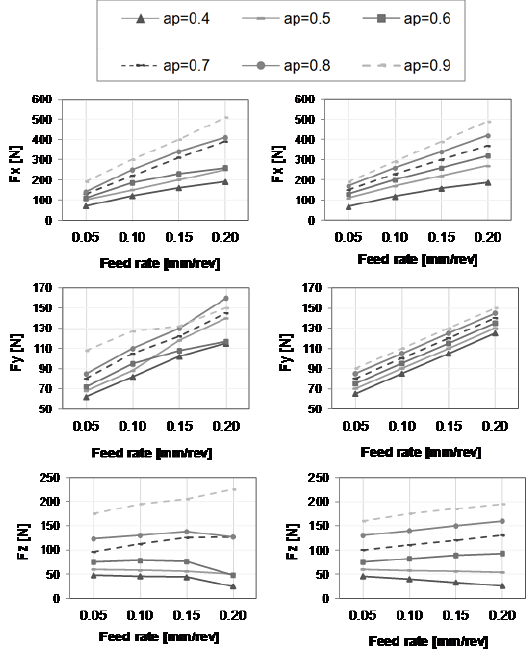
Figure 4: Experimental cutting forces without the wear effect and linearization for Vc = 250